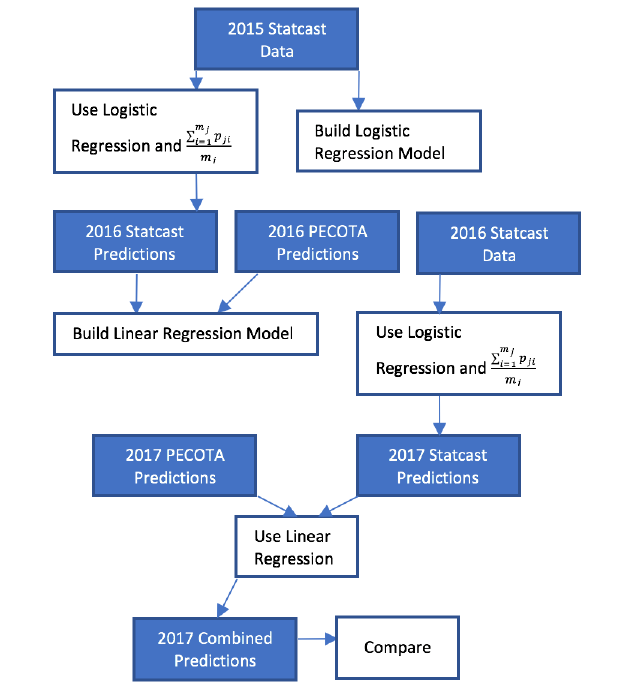
Figure 1. Overview of the